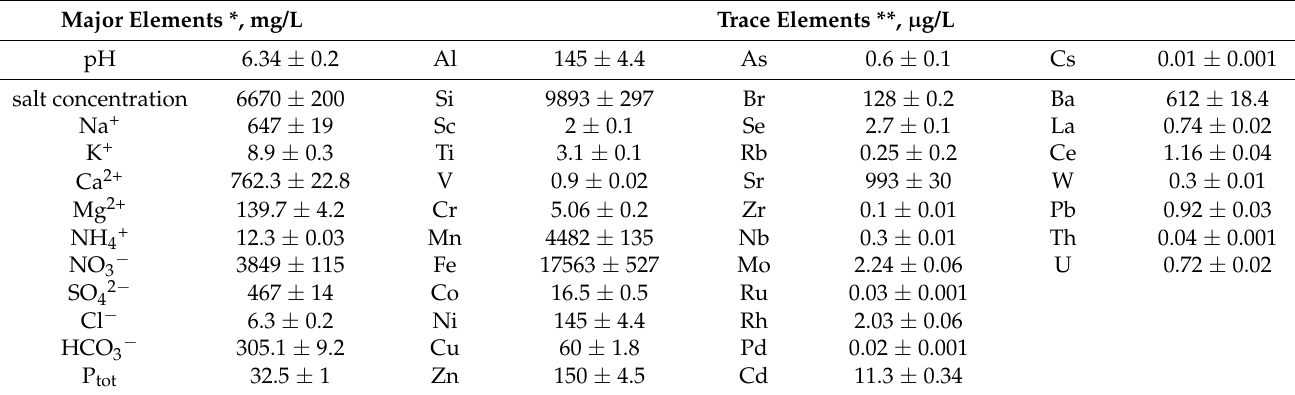
Table 1. Characteristics of the analyzed groundwater